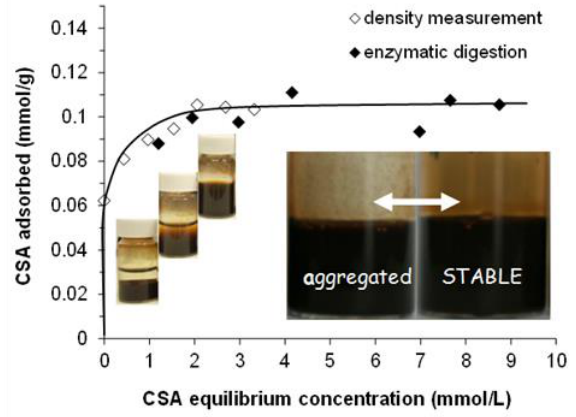
Figure 1. Adsorption isotherm of chondroitin-sulfate-A (CSA) on magnetite nanoparticles (MNP) at pH ~6.3 and 10 mM NaCl. With increasing CSA concentration, the colloidal state of samples changes characteristically from aggregated to stable, as seen in the vials. Stable CSA@MNP (see the inserted photos) can only be prepared under accurate conditions. (The amount of CSA is expressed through the number of repeating units in mmol. The line is drawn as a guide for the eye).